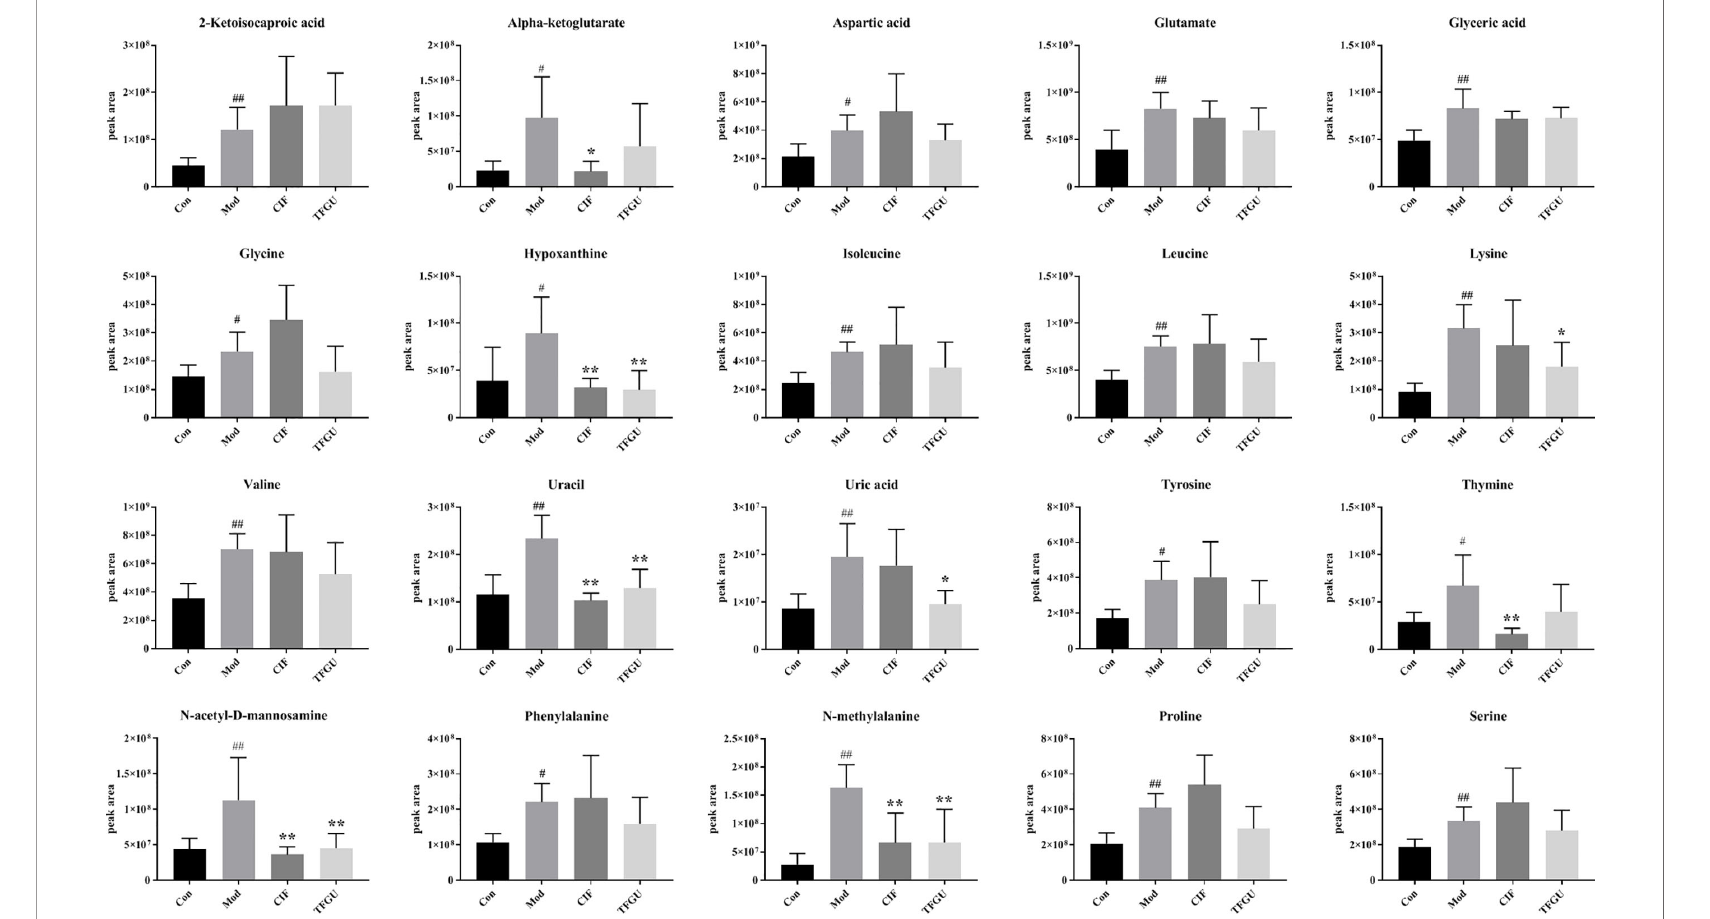
FIGURE 7 | Effects of TFGU on peak areas of the potential metabolites of between the Mod and Con groups for fecal samples. Date are shown as mean ± SD (n = 6 mice/group). # P < 0.05, ## P < 0.01 vs. Con group, while * P < 0.05, ** P < 0.01 vs. Mod